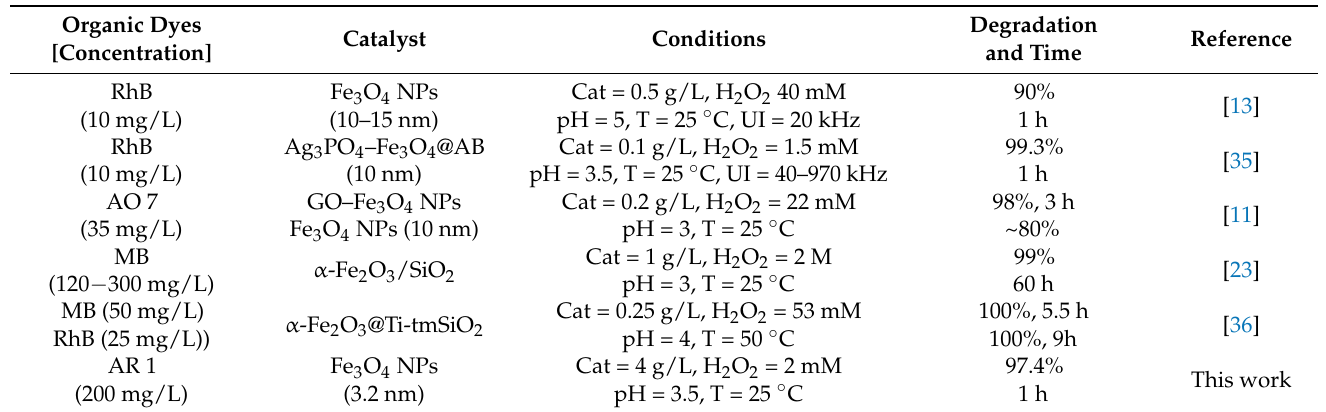
Table 1. Degradation studies of azo dyes using different nanomaterials and process conditions. Organic